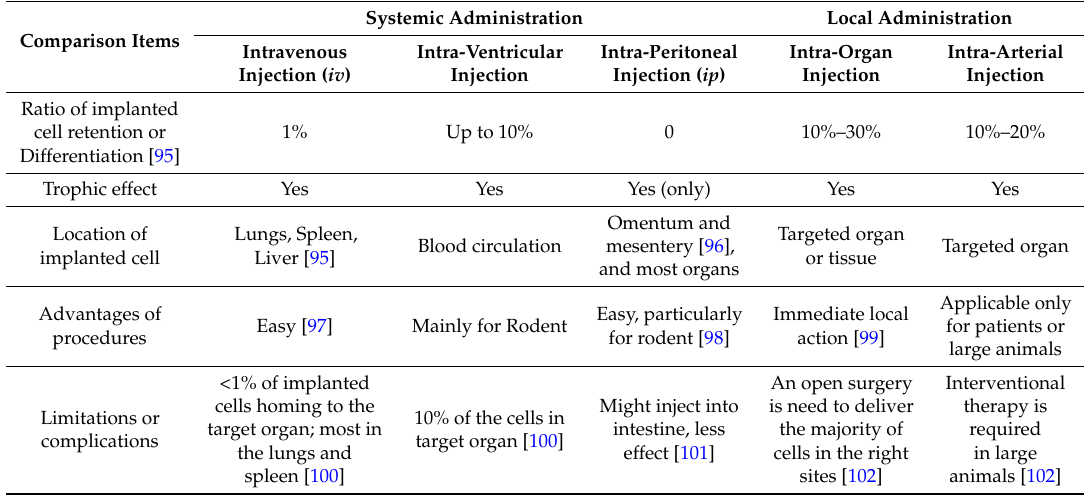
Table 3. Routes of stem cell implantation in solid organs in vivo